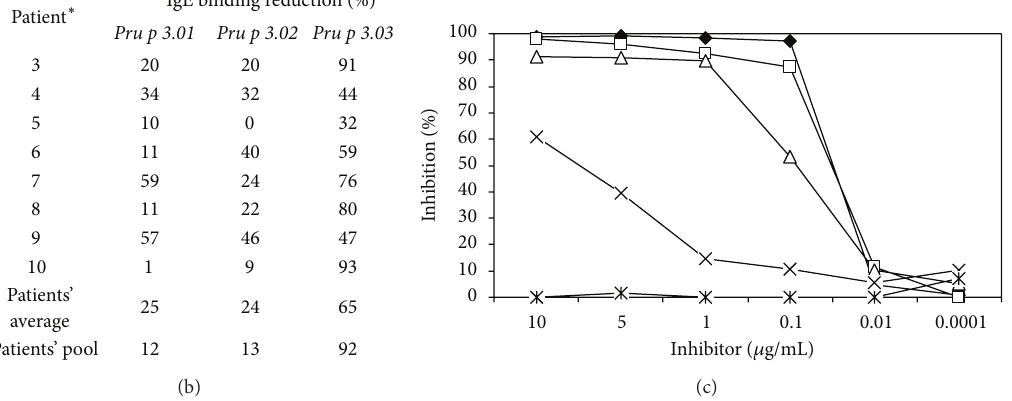
Figure 2: (a) Specific IgE to Pru p 3 forms (wild type, Pru p 3.01, Pru p 3.02, and Pru p 3.03 ), using sera from peach-allergic patients (single or pool; 1:2 dilution). Blocking solution without solid phase was used as a negative control, and optical density (OD) values > 0.189 units ( 𝑛 = 30 ; mean + 3x SD = 0.108 + 3 × 0.026 OD units) were considered positive. All tests were performed in triplicate. (b) Reduction of IgE binding capacity (%) of the mutants in comparison with wild type was calculated, taking as 100% the value obtained for Pru p 3 (5 𝜇 g/mL). ∗ The number of the patients corresponds to that in Table 1. (c) The inhibition percentage of the IgE binding capacity of wild type form is represented. Plates were covered with Pru p 3 (3 𝜇 g/mL), and Pru p 3.01, Pru p 3.0 , and Pru p 3.03 were used as inhibitors. All tests were performed in